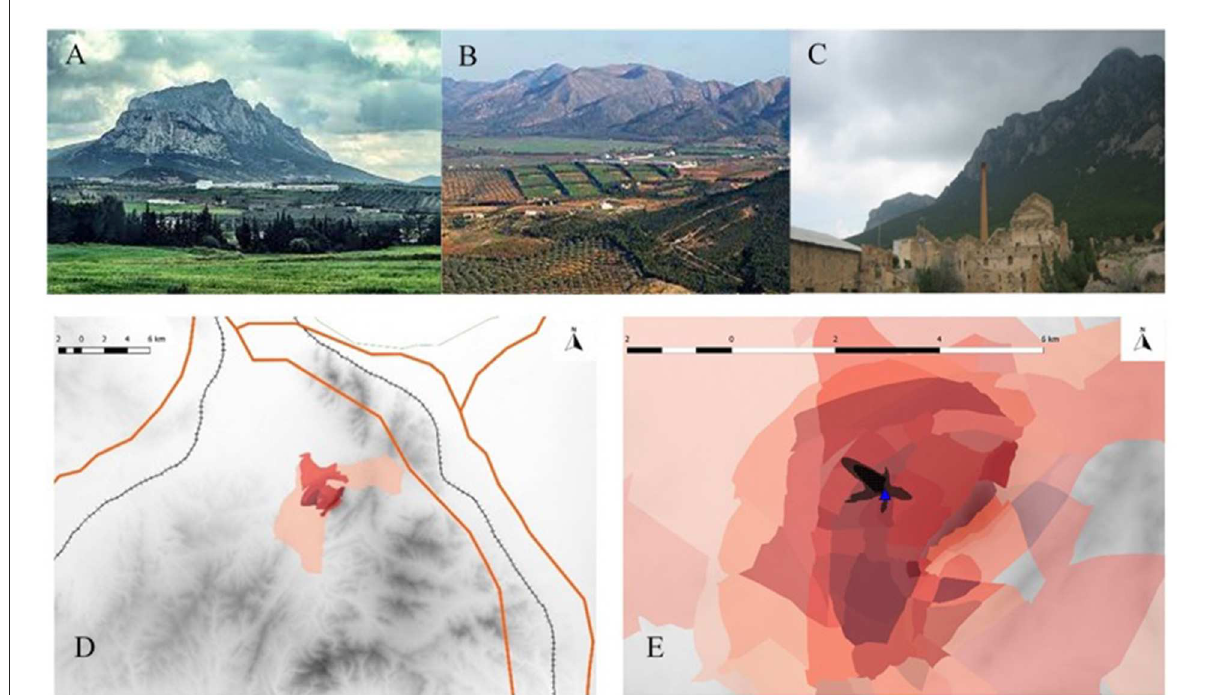
FIGURE4 (A) The Jebel Ressass dominating the Mornag Plain. (B) The plain itself seen from the Mont. (C) The remains of the mine (Photographs authors). (D) The Zone contaminated by aerial dispersion of the mine halves according to the aerial dispersion model of Ghorbel et al. (2010).